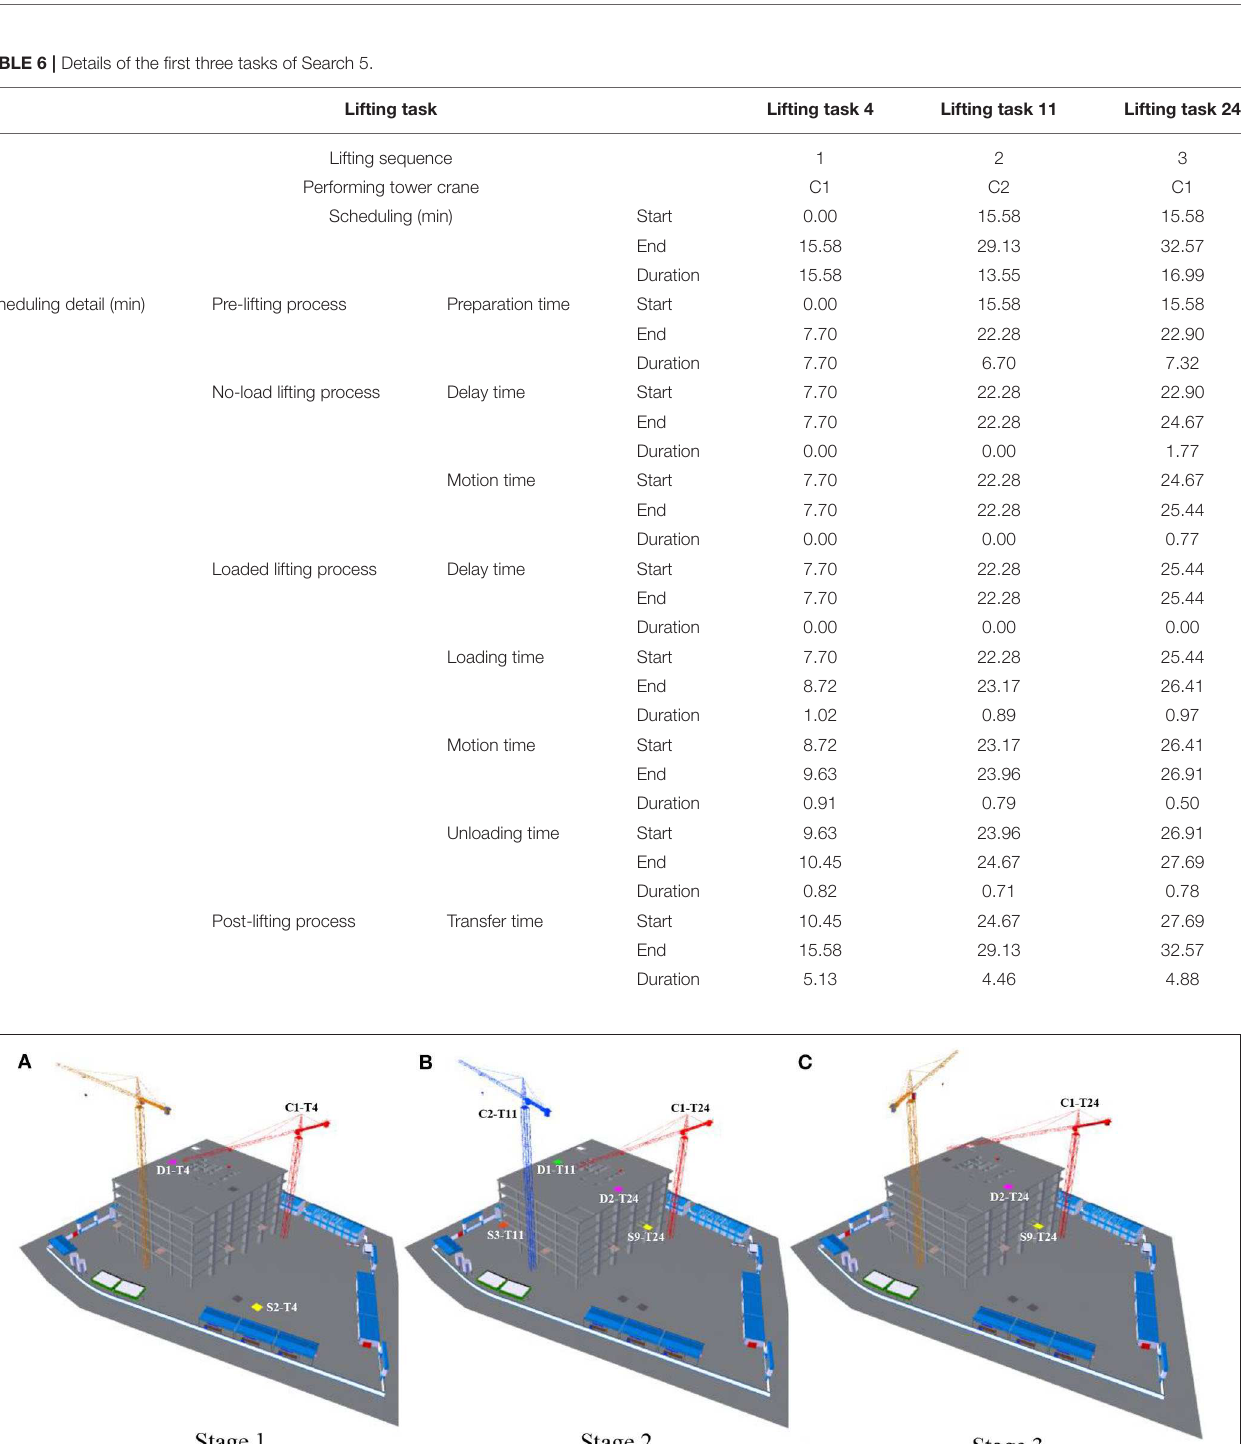
available, respectively, and they are marked using no color, dark orange, and no color, respectively; tower crane C1 (labeled C1-T24-1), supply point S9 (labeled S9-T24-1), and demand